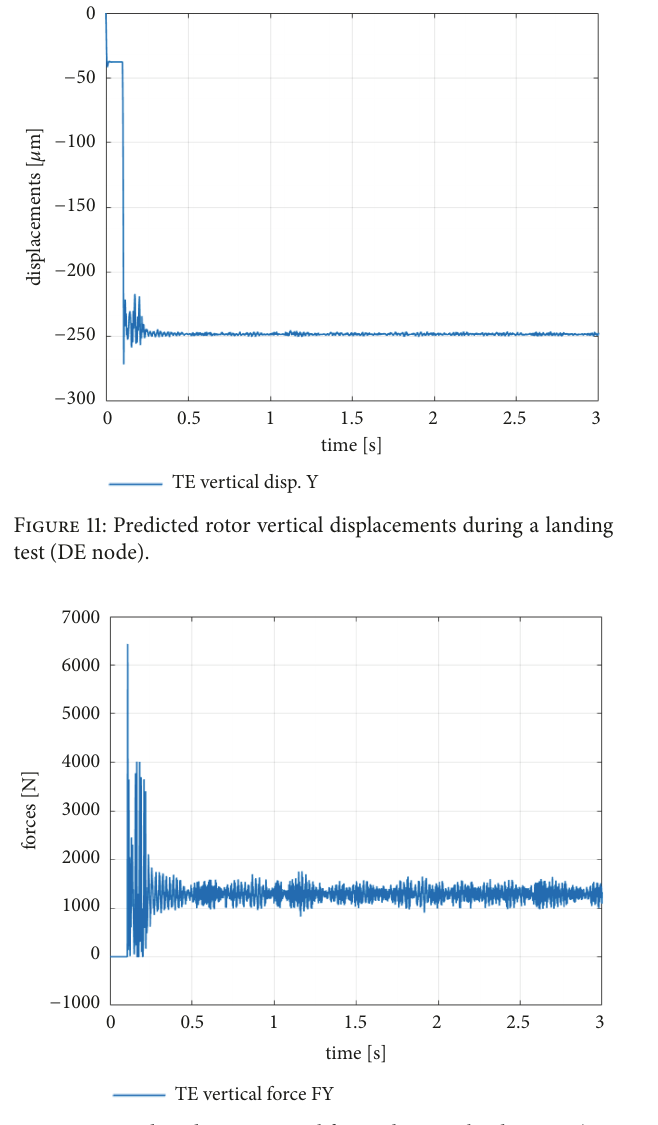
Figure 12: Predicted rotor vertical forces during a landing test (DE node).